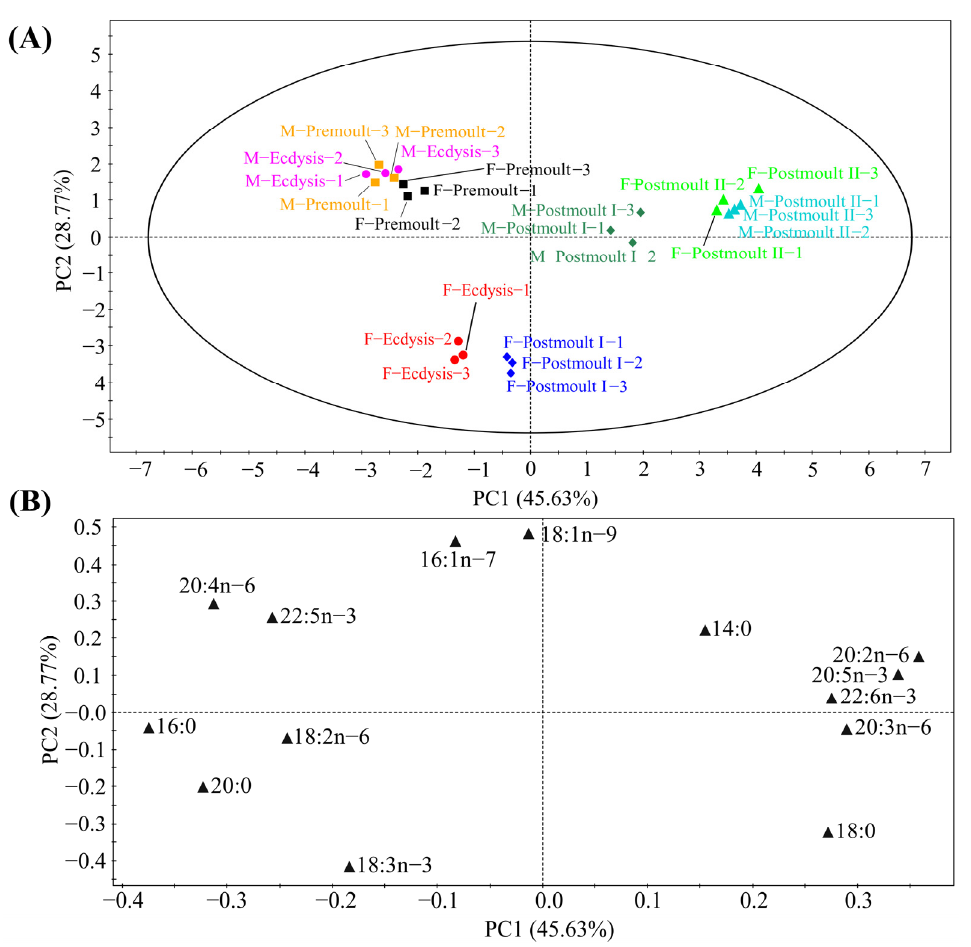
Figure 8. Principal component analysis (PCA) score plot ( A ) and loading plot ( B ) based on the fatty acid composition of mud crab.